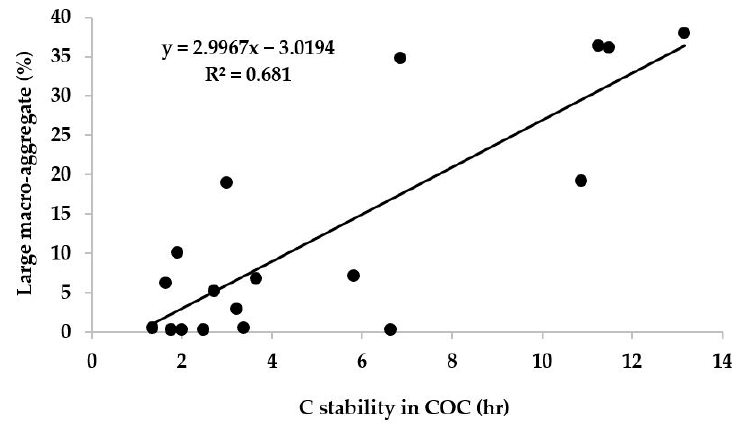
Figure 2. Relationship between C stability in clay–organic complex (COC) and aggregate-associated C (n = 18; p < 0.05).